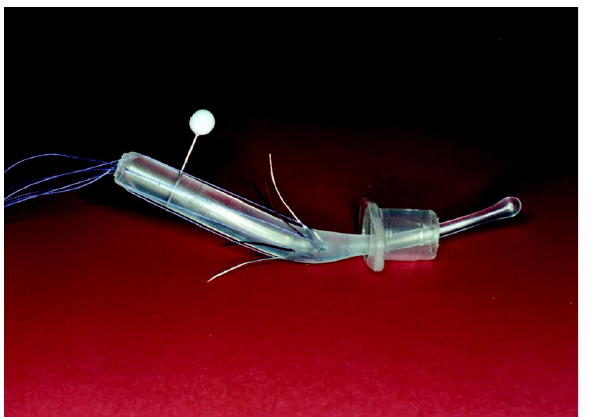
Figure 2 – Device showing the needles closed inside the cylin- der.